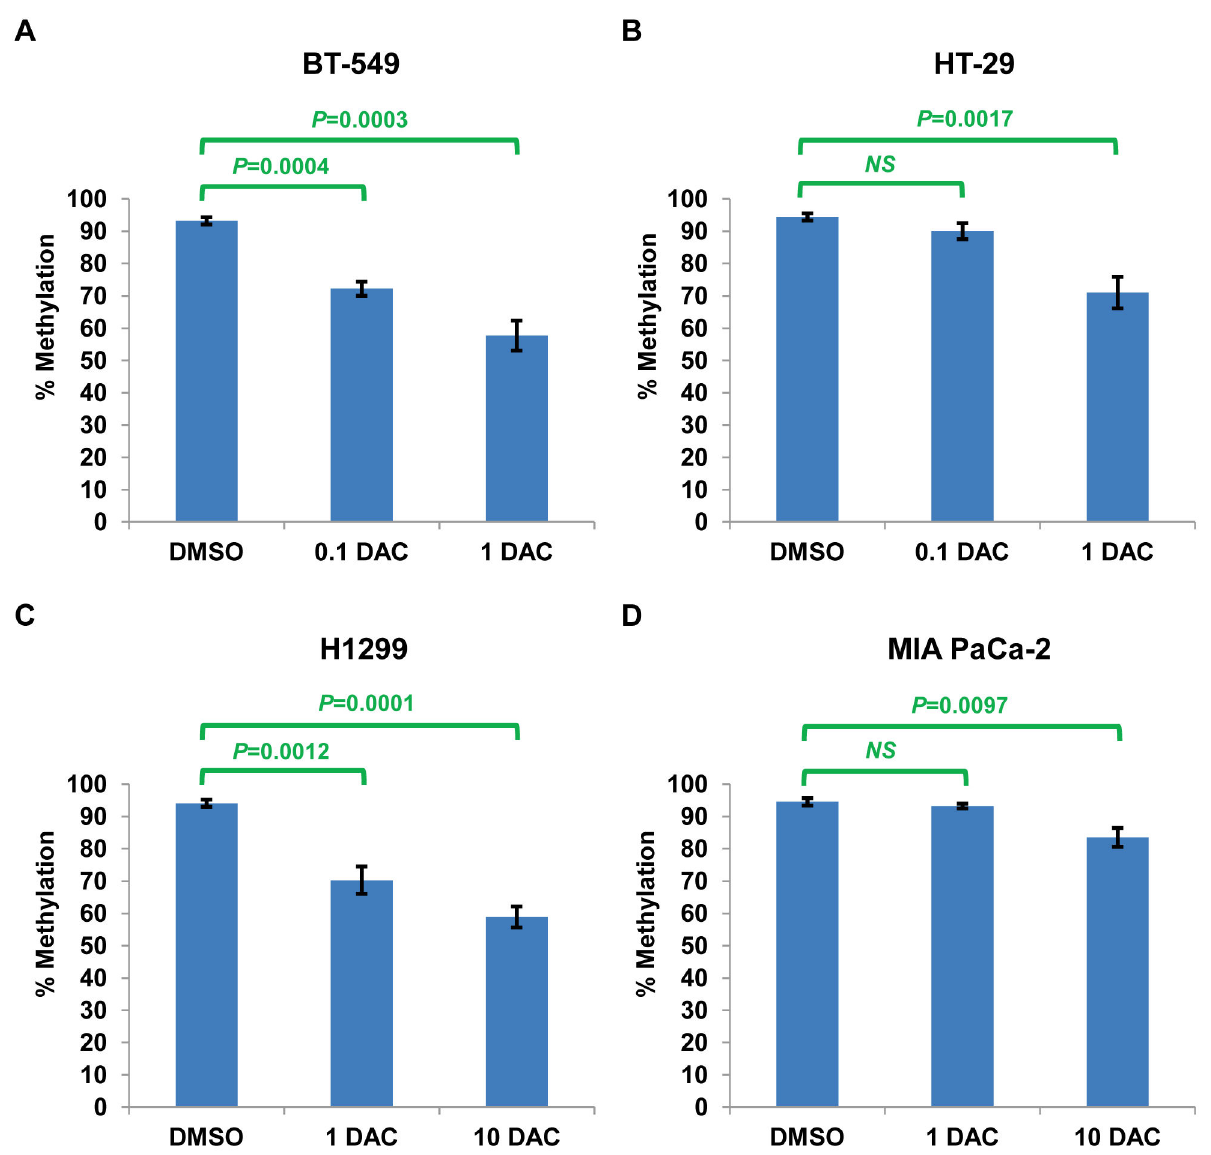
Figure 5. Association of reduced methylation in the FILIP1L promoter with restoration of FILIP1L expression in various cancer cells following treatment with a DNA demethylating agent. DNA methylation status of the CpG island in the FILIP1L promoter from the same cells used in Figure 4 was analyzed by Sequenom® EpiTYPER Mass Array. Mass Array results are shown as described in Figure 3A-D. The result is an average of two independent experiments. P values are derived from comparison between DMSO-treated control and each DAC-treated